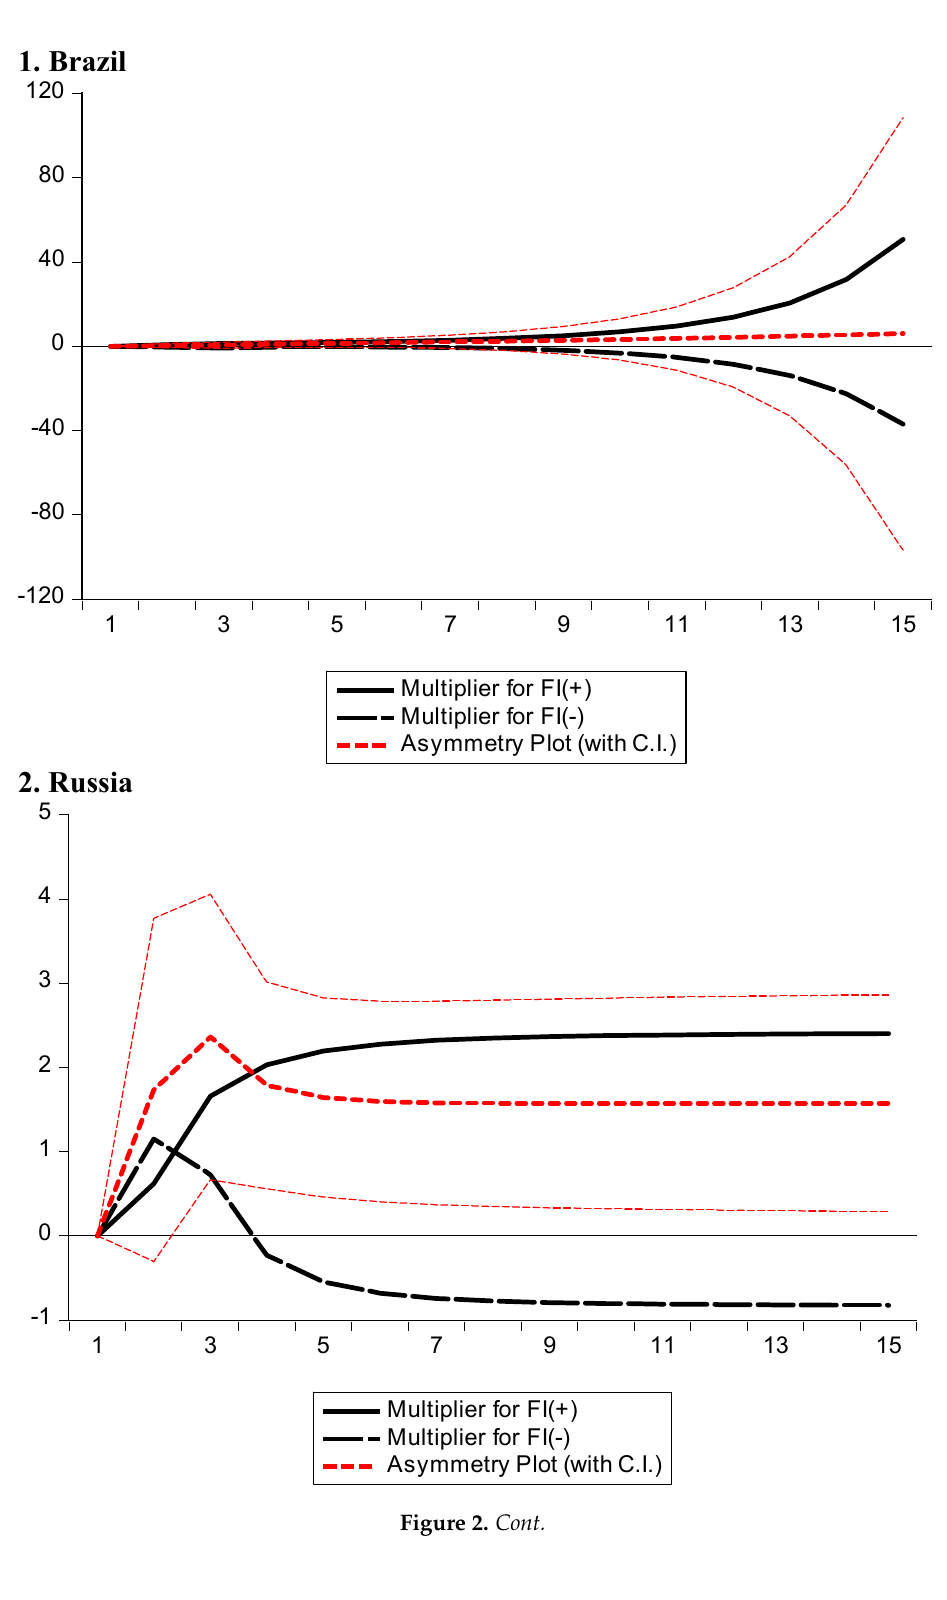
Multiplier for FI(+) Multiplier for FI(-) Asymmetry Plot (with C.I.) Figure 2.